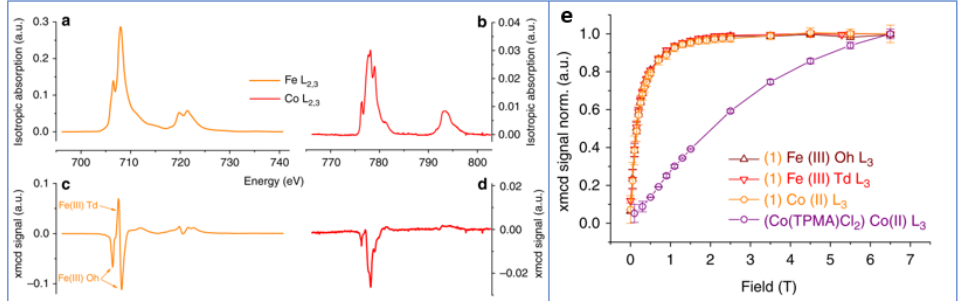
Figure 5. XAS and XMCD signals measured on [Co II (TPMA)Cl 2 ] functionalized sample at the Fe ( a , c ) and Co ( b , d ) L 2,3 edges at 5 K and 6 T. Fe-specific and Co-specific XMCD-detected magnetization curves at 5 K ( e ). The Figure is reprinted with permission from Prado et al. [47].